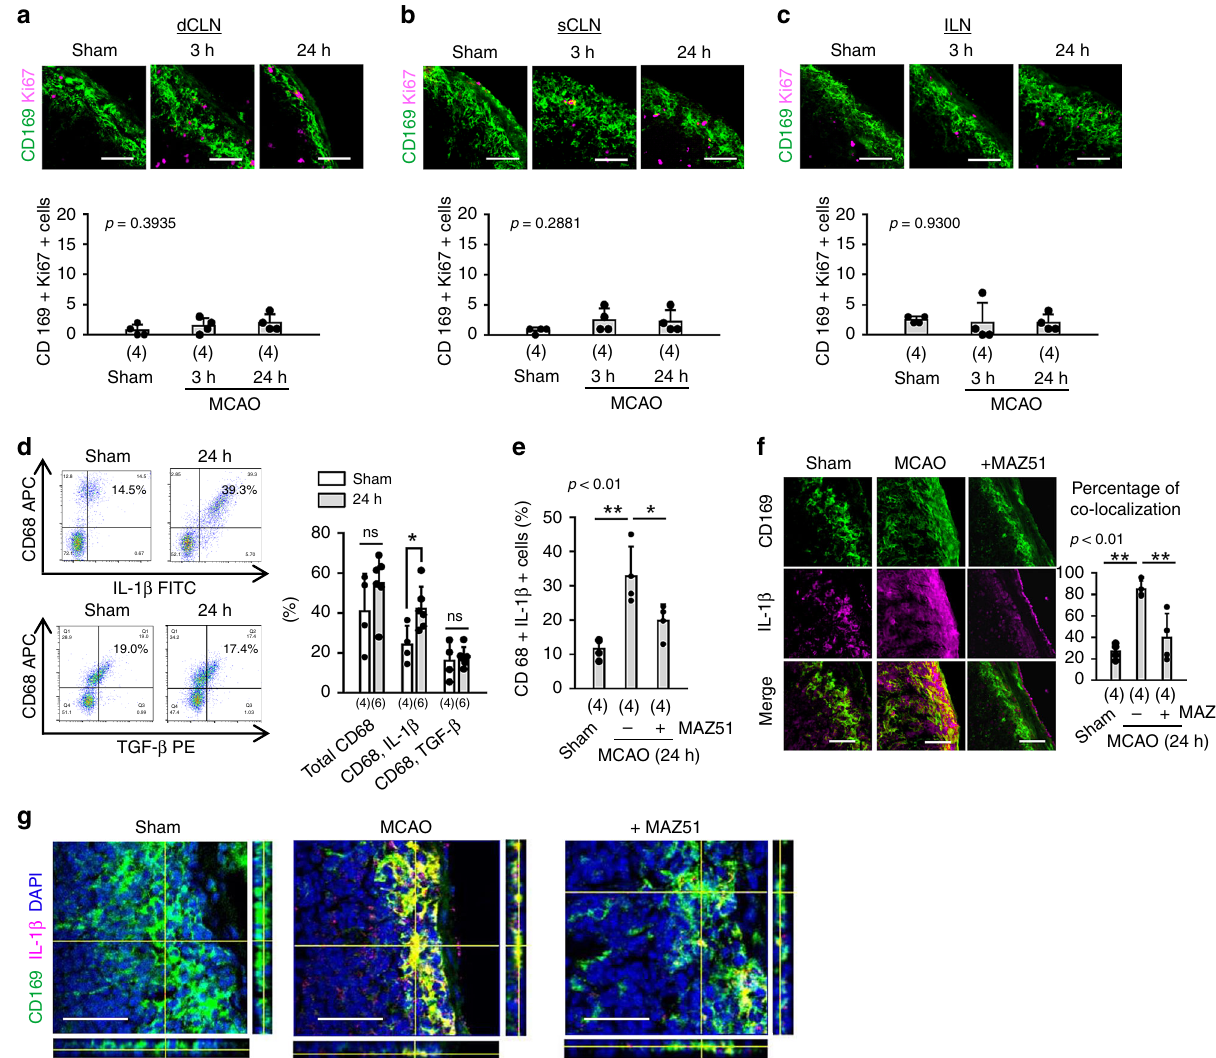
Fig. 2 Macrophage activation in rat CLNs after stroke: a – c Male SD rats were subjected to 100min of transient focal cerebral ischemia. Deep and super fi cial CLNs, and ILNs were collected and analyzed by immunohistochemistry. Lymph node resident CD169 positive macrophages co-labeling with Ki67 were identi fi ed as proliferating cells. Immunostaining showed that macrophage proliferation was slightly but not signi fi cantly increased in CLNs after focal cerebral ischemia ( n = 4 biologically independent animals). Scale: 100 nm. One-way ANOVA followed by Fisher ’ s LSD test. d In fl ammatory factors, including prototypical cytokines such as interleukin-1 β (IL-1 β ) and transforming growth factor beta (TGF- β ), were analyzed, by fl ow cytometry analysis, in CD68 positive macrophages. After stroke, IL-1 β positive macrophages were increased in super fi cial CLNs, but TGF- β positive subsets did not change (Sham; n = 4, MCAO; n = 6 biologically independent animals). * P < 0.05 vs Sham, one-way ANOVA followed by Fisher ’ s LSD test. e Intracerebroventricular injection of MAZ51 (50ng/5 µ L) signi fi cantly reduced IL-1 β positive macrophages ( n = 4 biologically independent animals). * P < 0.05, ** P < 0.01, one-way ANOVA followed by Fisher ’ s LSD test. f , g Immunohistochemistry con fi rmed that CD169 positive macrophages expressed IL-1 β after focal cerebral ischemia